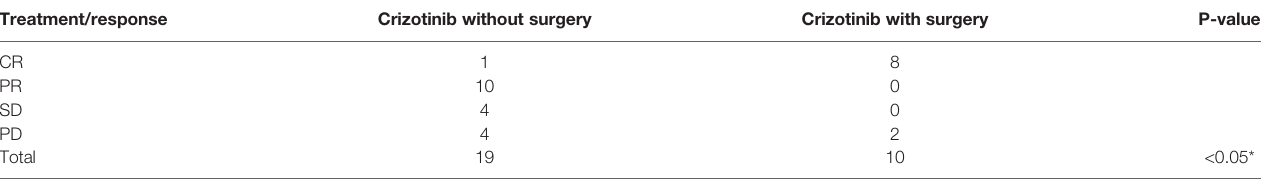
TABLE 3 | Response to crizotinib therapy with or without surgery in patients with sarcomatous malignancies.